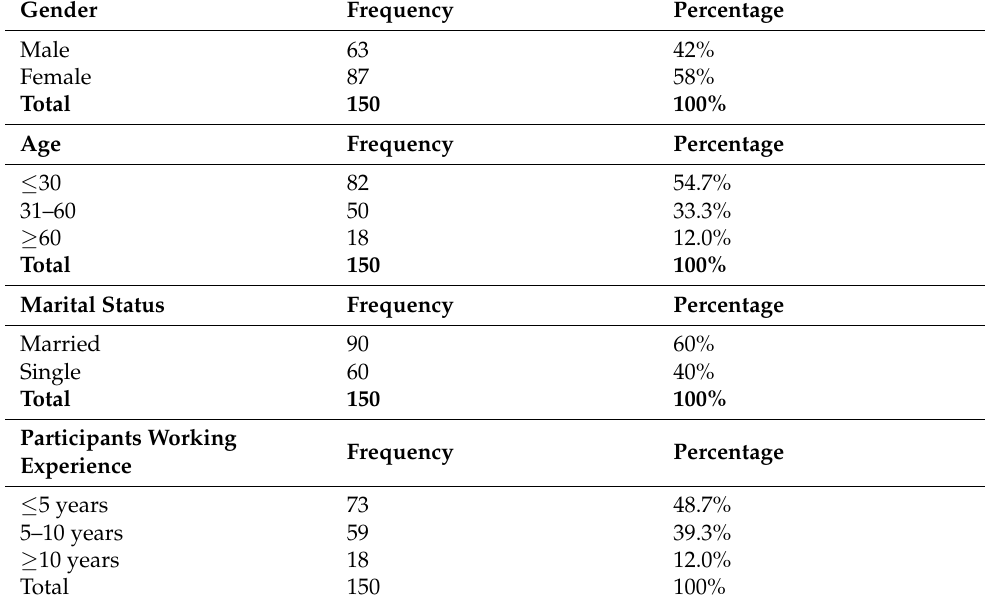
Table 1. Sample demographic